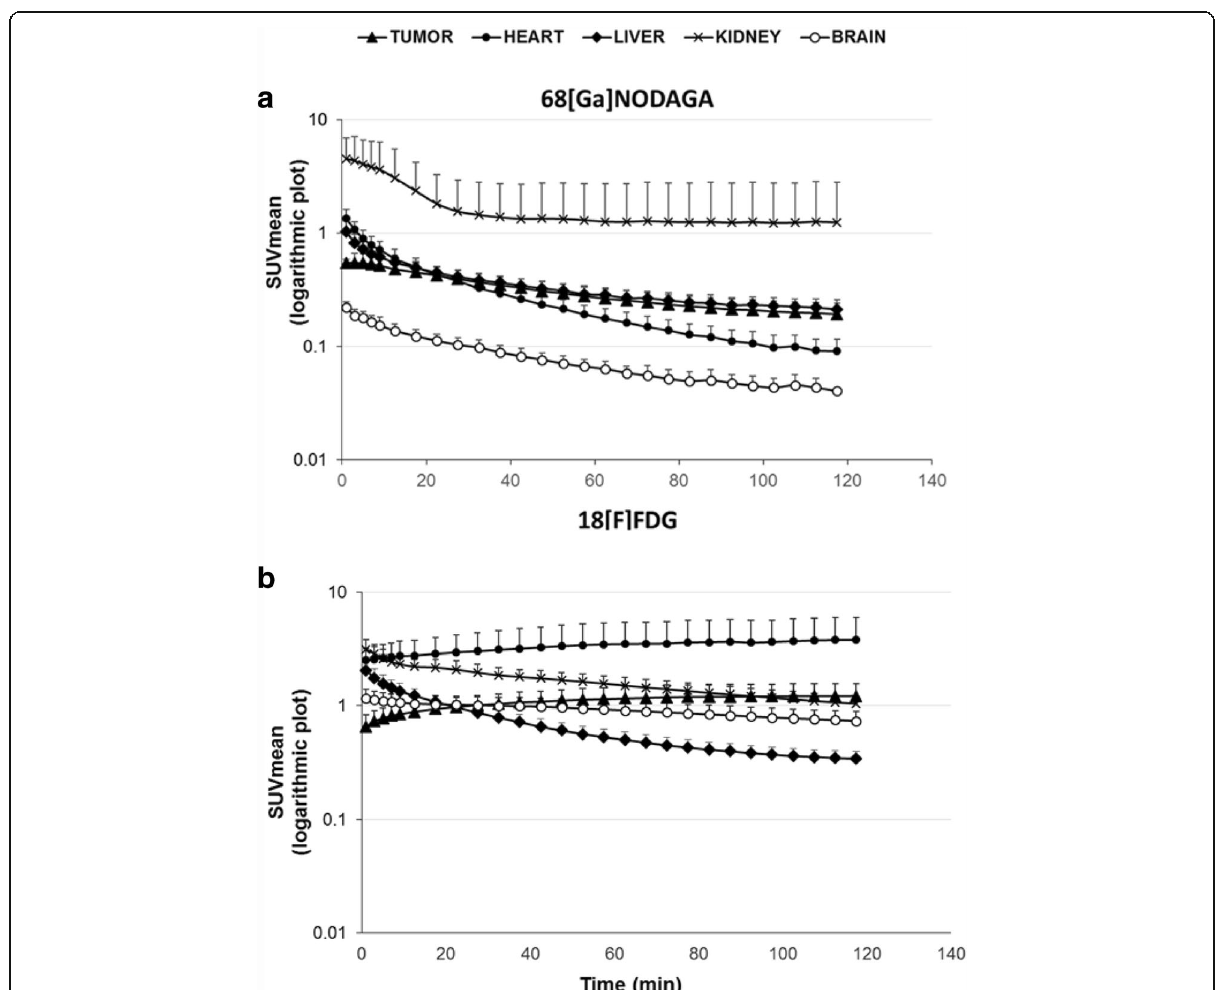
Fig. 1 Time-activity-curves derived from the 120-min PET recordings following the intravenous injection of 68 Ga-NODAGA-RGD ( a ) or 18 F-FDG ( b ) ( n =17 for both tracers) and expressed after logarithmic transformation of the mean±SEM values for the SUVmean from the kidneys (black crosses), tumor (black triangles), heart (black circles), brain (white circles), and liver (white